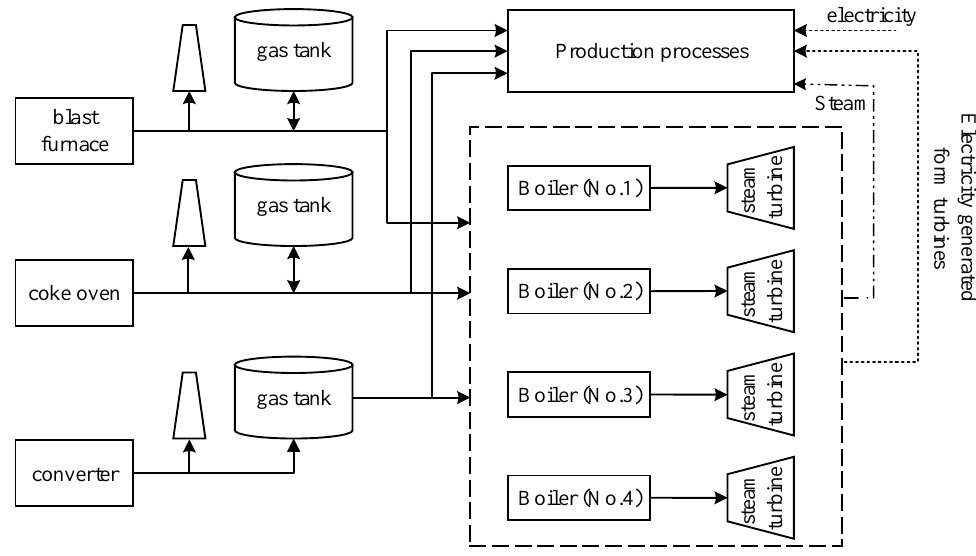
Figure 1. A simple diagram of byproduct gas distribution in an iron and steel plant.